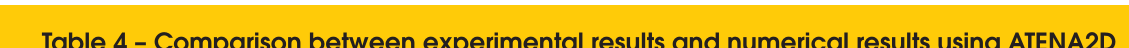
Table 4 – Comparison between experimental results and numerical results using ATENA2D